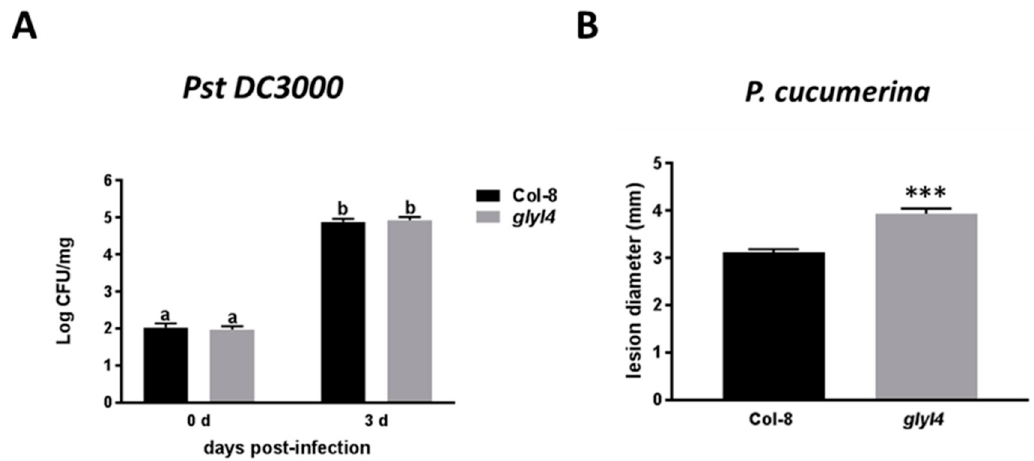
Figure 7. Bacterial proliferation and disease rate in Arabidopsis Col-8 and glyI4 plants infected with Pst DC3000 and P. cucumerina, respectively. ( A ) Plants were challenged with Pst DC3000 by dipping the aerial part in a bacterial suspension (10 6 colony-forming units (CFU) / mL). The values reported represent means of the log of the proliferation values, recorded at zero and three days post inoculation. Data represent the average from six infected plants. The experiment was repeated two more times with similar results. Error bars represent SEM. Di ff erent letters mean significant statistical di ff erences (Two-ways ANOVA, Tukey’s post-hoc, p < 0.0001). ( B ) Plants were infected with P. cucumerina by inoculating leaves with 6 L-drop of a suspension containing 5 × 10 6 conidia / mL. Disease symptoms were recorded at seven days post inoculation by measuring the diameter of the necrotic lesions (mm). The figure shows a representative experiment from three independent repetitions. Data represent the average from 45 lesions produced on 12 plants per genotype. Error bars represent SEM. Asterisk indicates significant statistical differences compared with Col-8 (t-test, *** p < 0.0001).